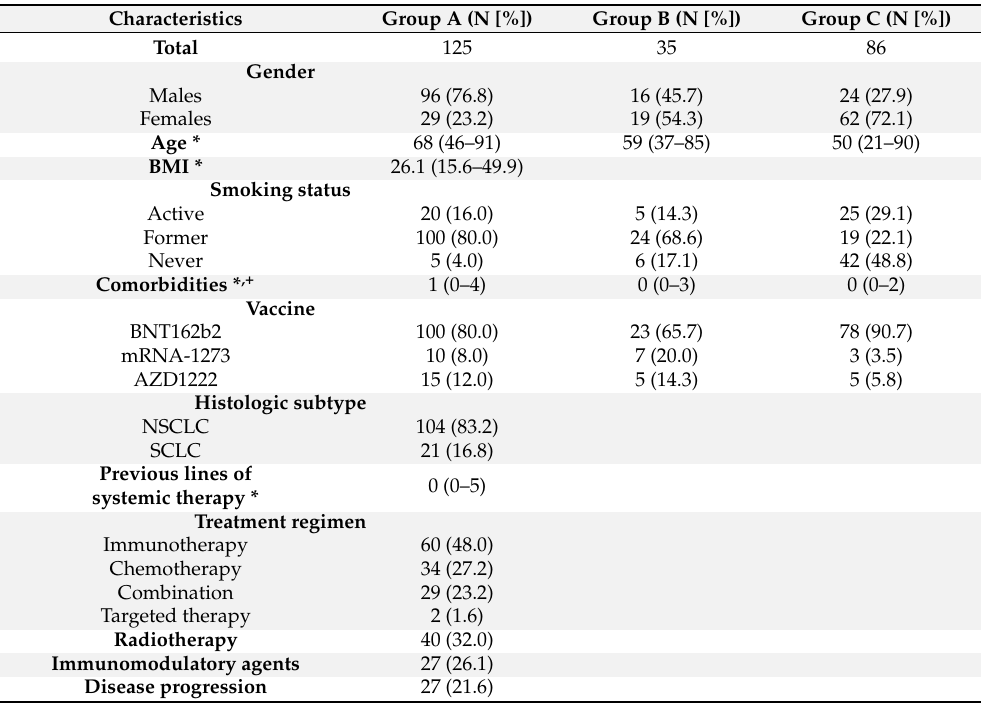
Table A1. Clinicopathologic characteristics of lung cancer patients (Group A).